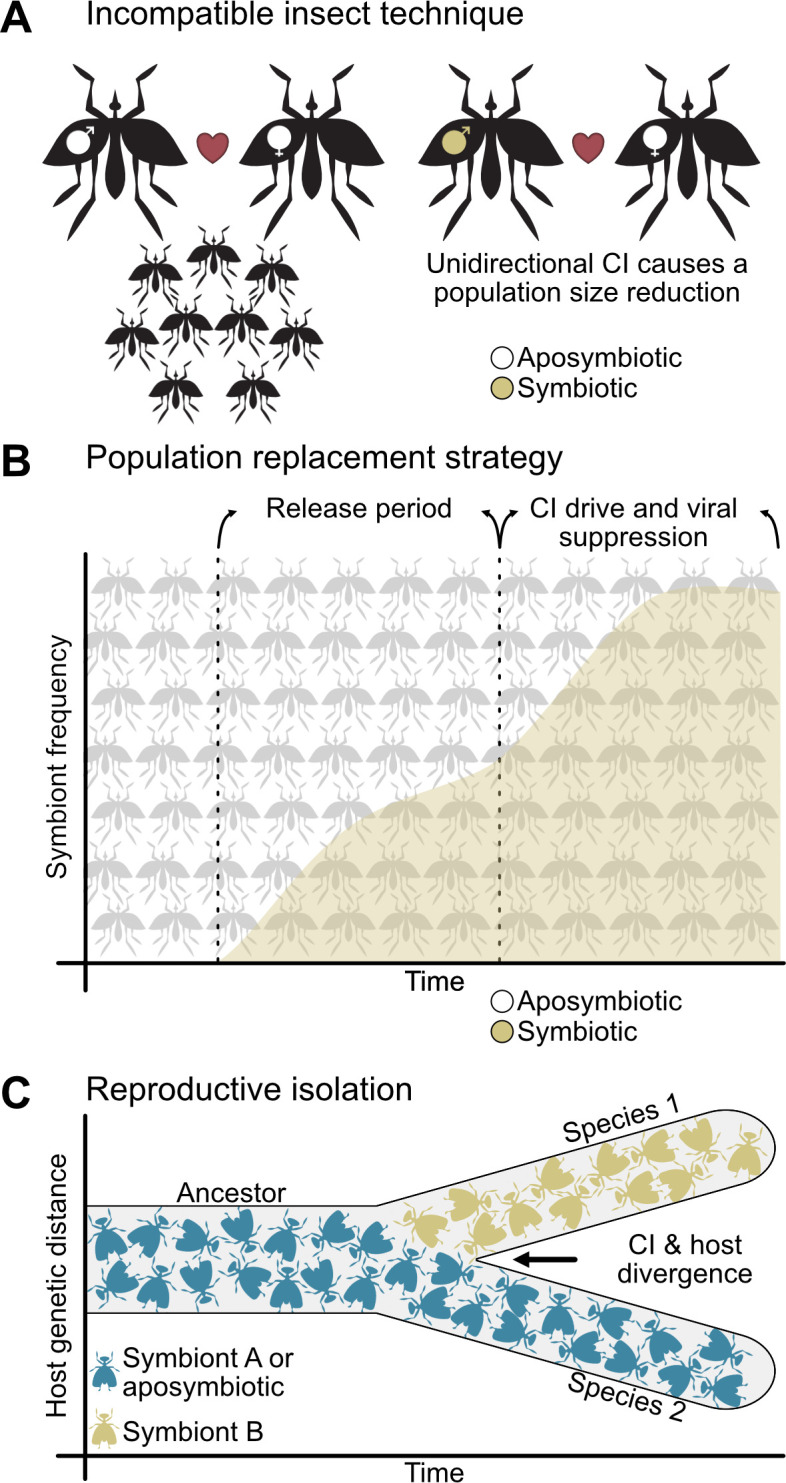
CI is important to vector control and reproductive isolation between species.(A) The incompatible insect technique is used to reduce population sizes (Crawford et al., 2020; Laven, 1967). Typically, two aposymbiotic individuals will mate and produce viable offspring (left), but if males bearing CI-inducing symbionts are released into the population, then they will cause unidirectional CI when they mate with aposymbiotic females (right) or bidirectional CI when they mate with females harboring incompatible symbionts (not shown). This yields a reduction in egg hatching and population size. (B) The population replacement strategy involves the release of both males and females bearing CI-inducing and pathogen blocking symbionts (Hoffmann et al., 2011; O'Neill, 2018). After a period of releases, CI will spread the symbiont to high frequencies where it can block the replication of human diseases. (C) CI-inducing symbionts can cause reproductive isolation through unidirectional or bidirectional CI when different individuals, populations, or species have different incompatible symbiont states (Bordenstein et al., 2001; Breeuwer and Werren, 1990; Gebiola et al., 2017; Jaenike et al., 2006). This reproductive barrier reduces gene flow between hosts with different symbiont states, allowing for their divergence.